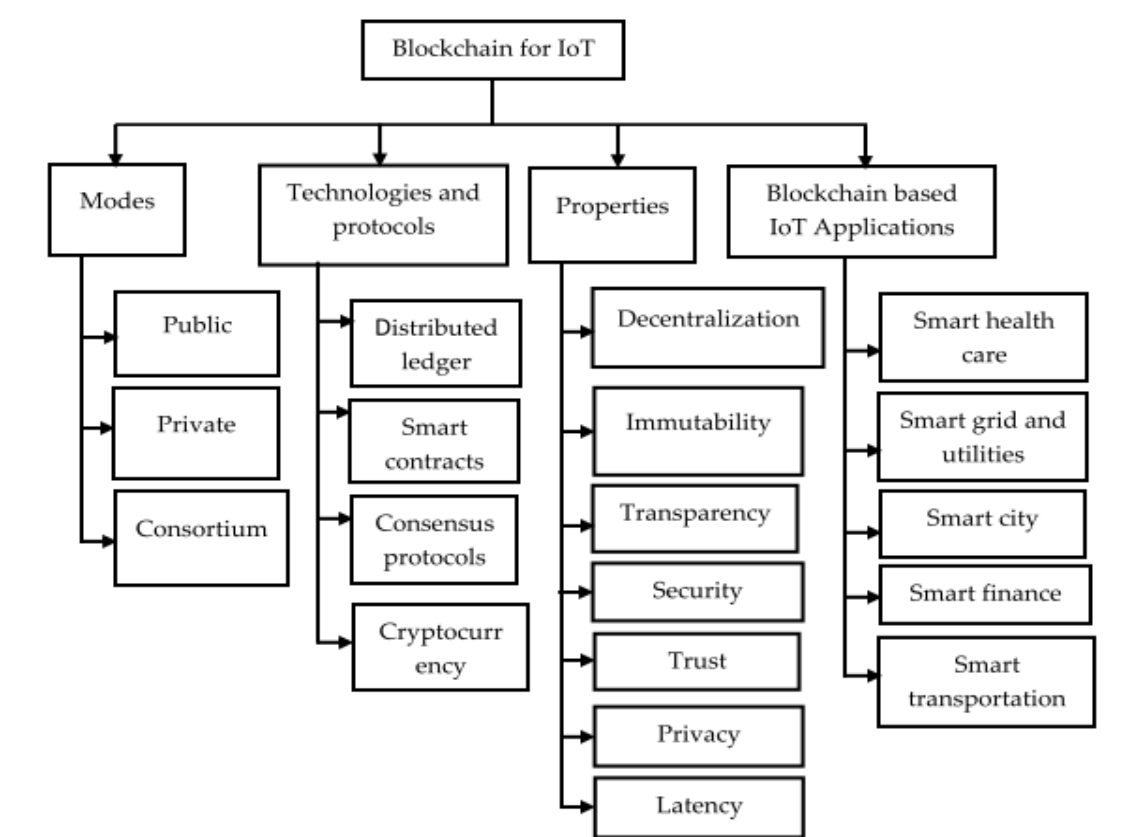
Figure 1. Thematic taxonomy of blockchain.